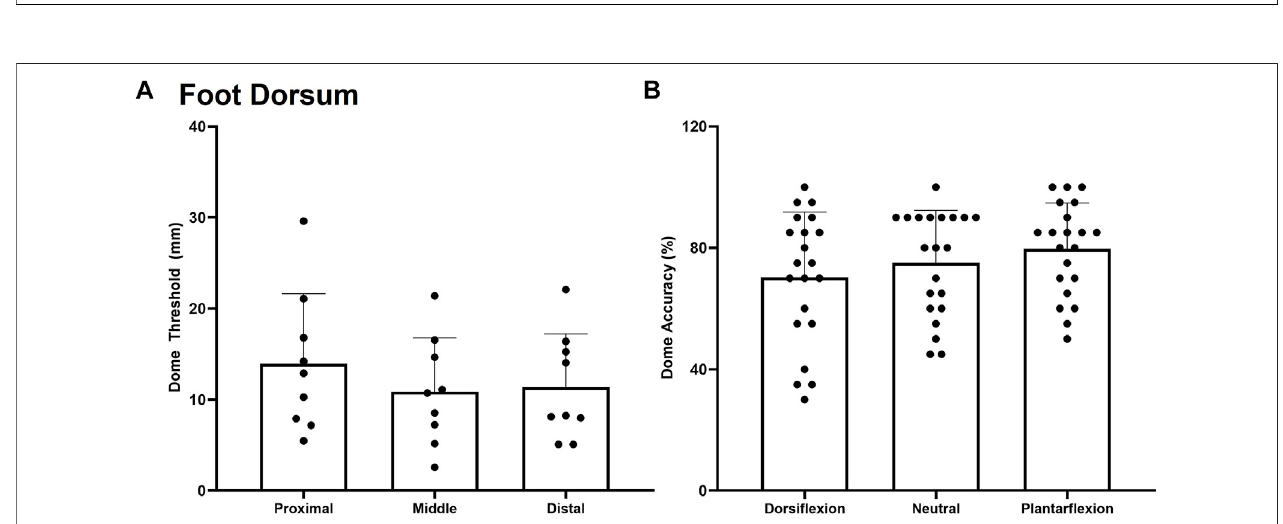
FIGURE 6| Mean (+SD) spatial acuity threshold across each ofthe foot dorsum testing locations. Nosigni fi cantdifference was found between test sites (A) or trial accuracy on the foot dorsum for the various postures (B) ( p < 0.05). Dots represent threshold values for each participant.